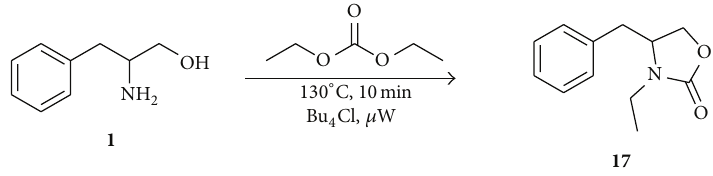
Scheme 5: Microwave reaction of dl-phenylalaninol, DEC, and TBAC.